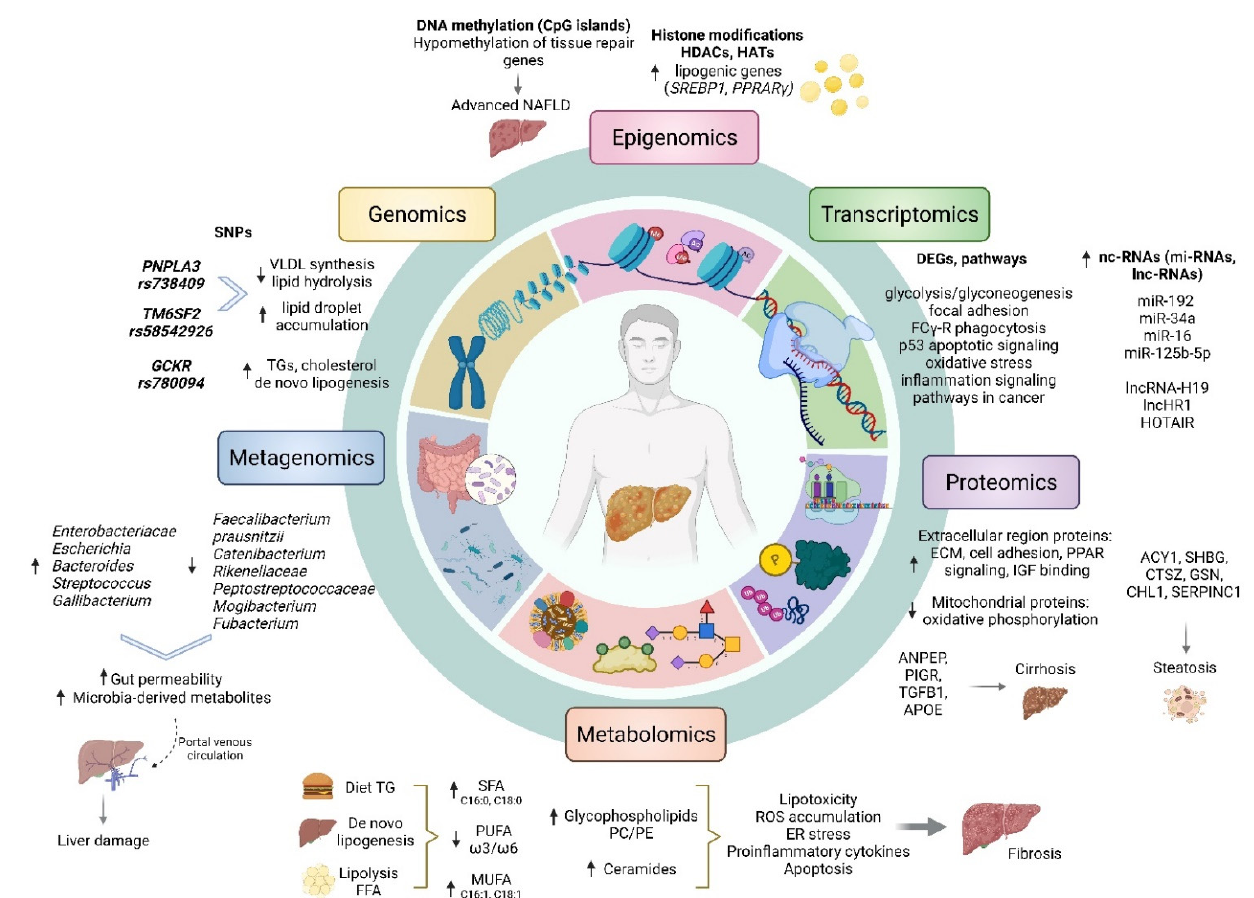
Figure 2. An overview of the omics modifications in NAFLD pathogenesis and their potential role as diagnostic biomarkers (created with BioRender.com, accessed on 21 December 2021). ACY1: Aminoacylase 1,